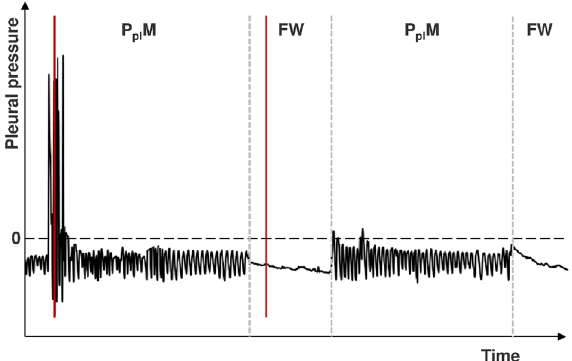
Figure 2. An example of pleural pressure record during therapeutic thoracentesis. The figure depicts 2 measurement periods (P pl M) and 2 fluid withdrawal periods (FW) with red, vertical lines outlined during the procedure indicating cough episodes during P pl M and FW. These markings were used to identify cough episodes during off-line analysis. Note that during P pl M the cough episode (red line) corresponds with peaks of P pl ; in contrast, as P pl is not registered during FW, cough can be identified exclusively by the marking drawn during the procedure. As depicted, no cough episodes occurred during the second P pl